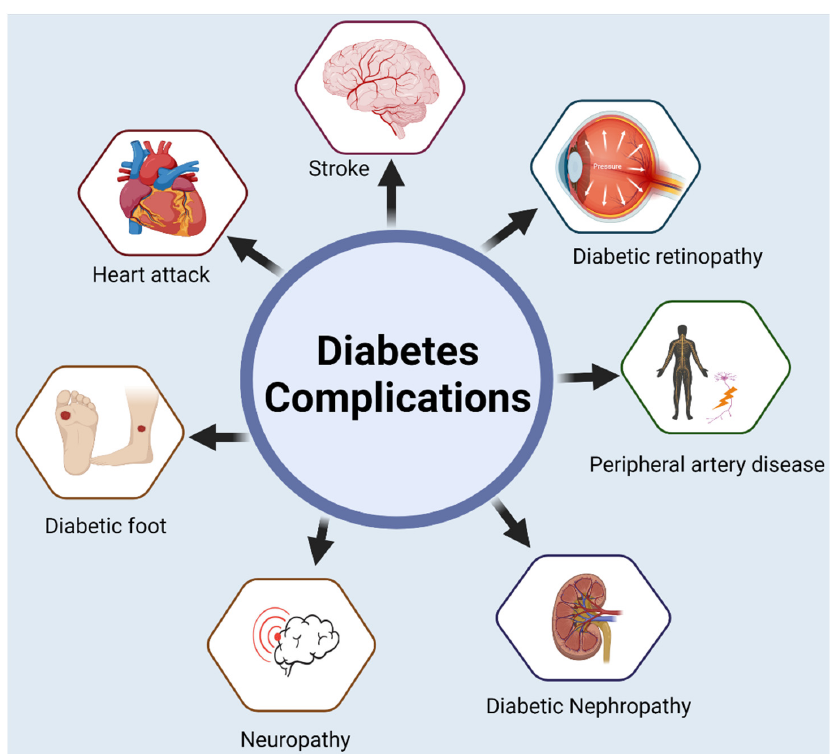
Figure 3. Diabetes affects multiple body functions and leads to complications such as stroke, diabetic retinopathy, heart disease, foot ulcer, and kidney disease. Created with BioRender.com. retinopathy, heart disease, foot ulcer, and kidney disease. Created with